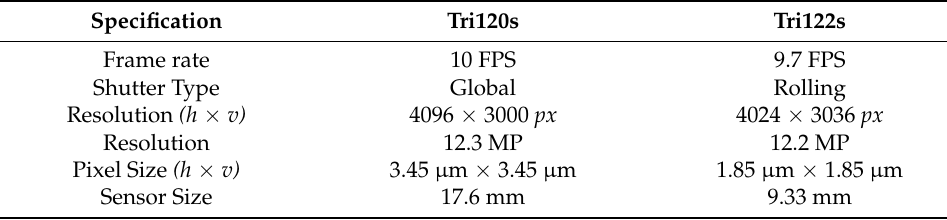
Figure 7. RODIS implementation on site. Table 3. Inspection camera specifications.